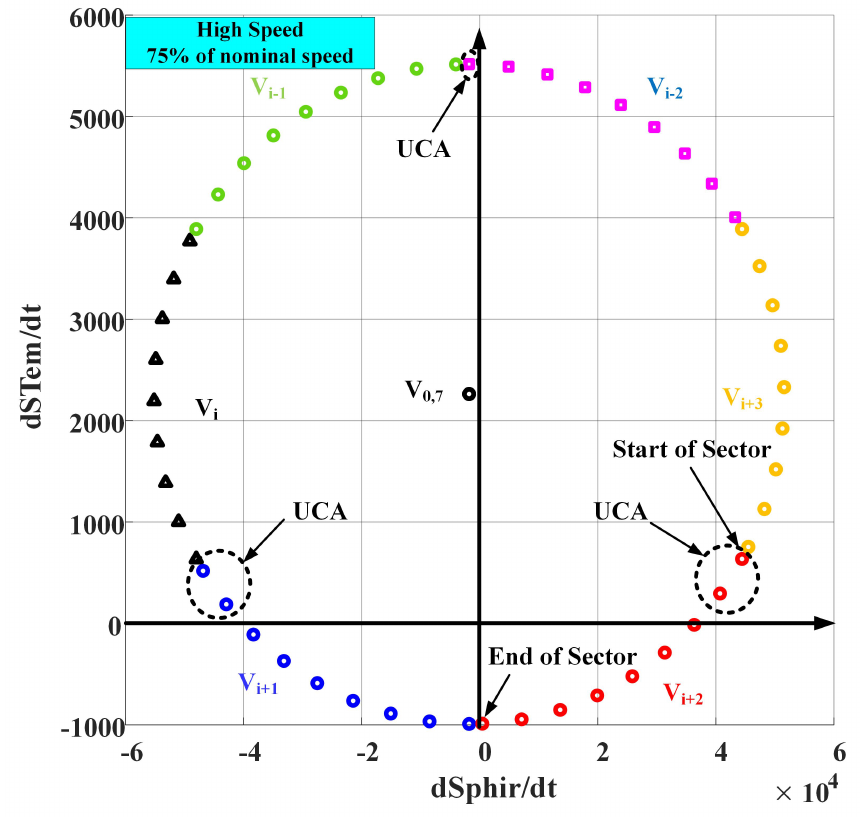
Figure 3. Values of dS Φ r and dS Tem for positive high speed ( 75% ω n )